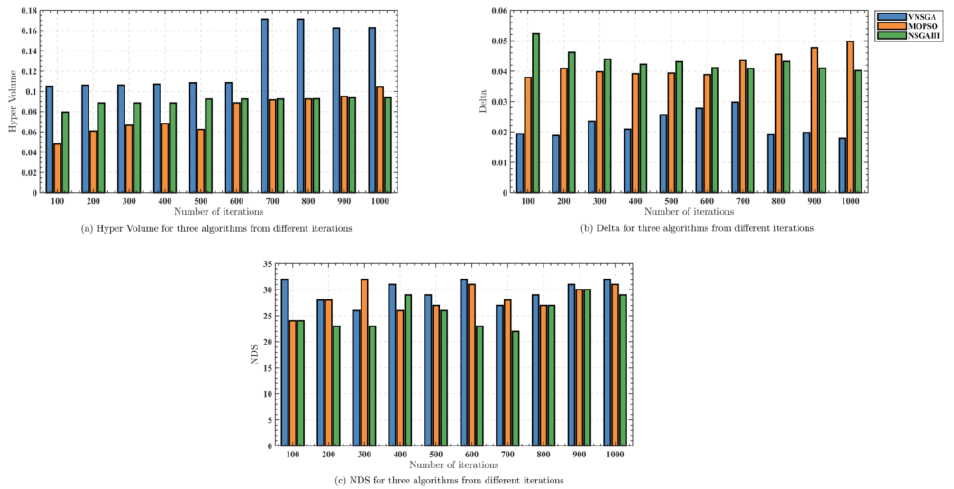
Figure 23. Hyper volume, Delta, and NDS for three algorithms from different iterations with respect to area B.